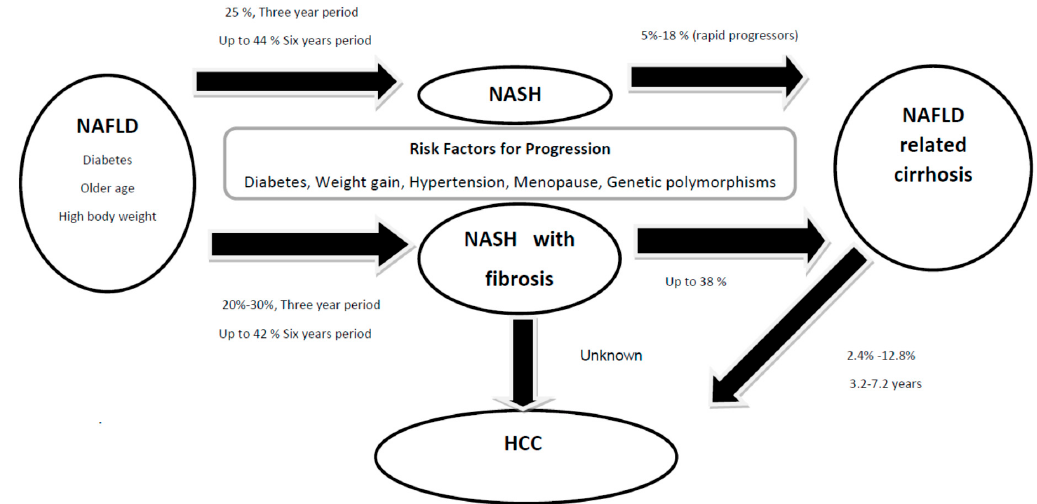
Figure 1. Progression of non-alcoholic fatty liver disease (NAFLD) to non-alcoholic steatohepatitis (NASH) with or without fibrosis, cirrhosis, and hepatocellular carcinoma. Data adapted form [7–9] and [24].